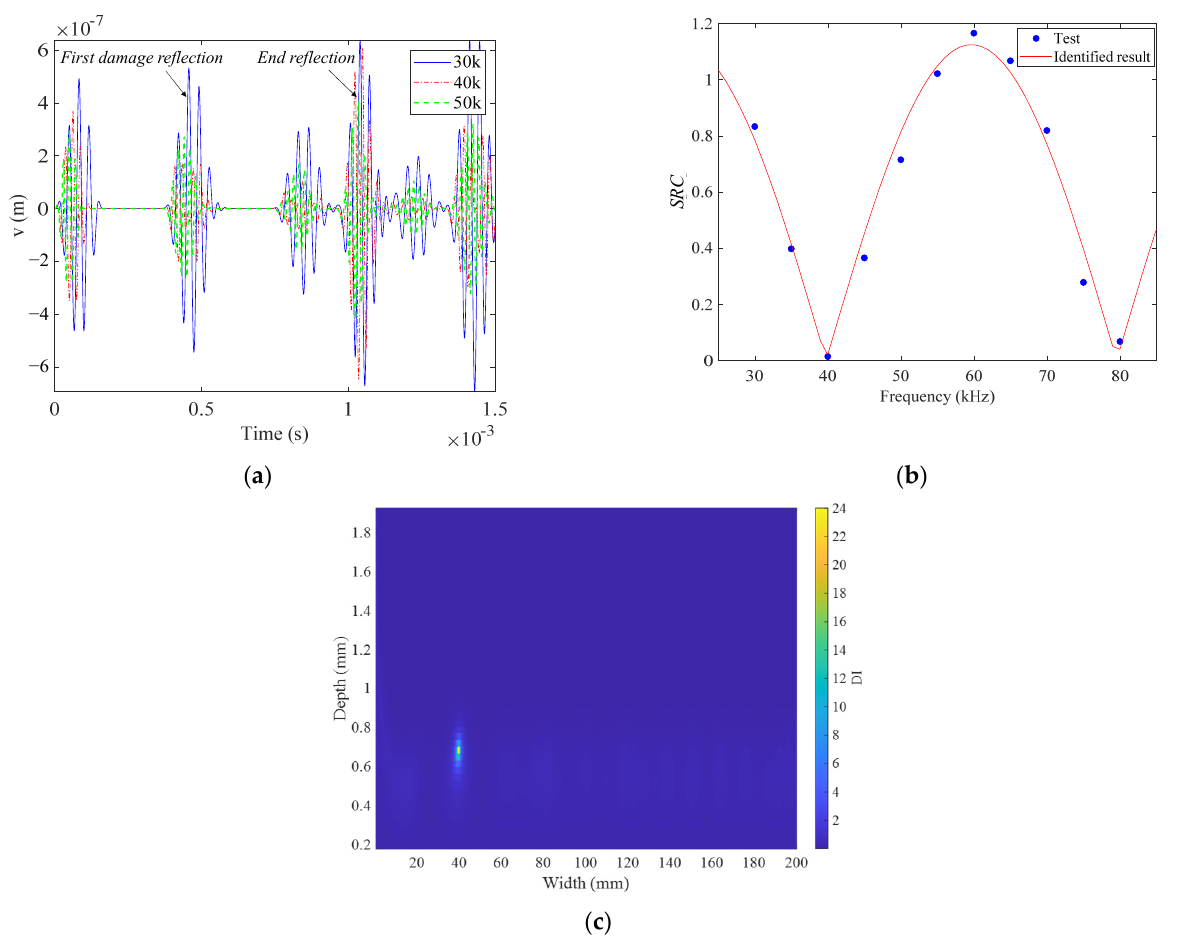
Figure 8. ( a ) Typical responses at different frequencies; ( b ) variation of the SRC with respect to the excitation frequency; ( c ) damage image for the 39 mm-wide and 0.7 mm-deep defect.